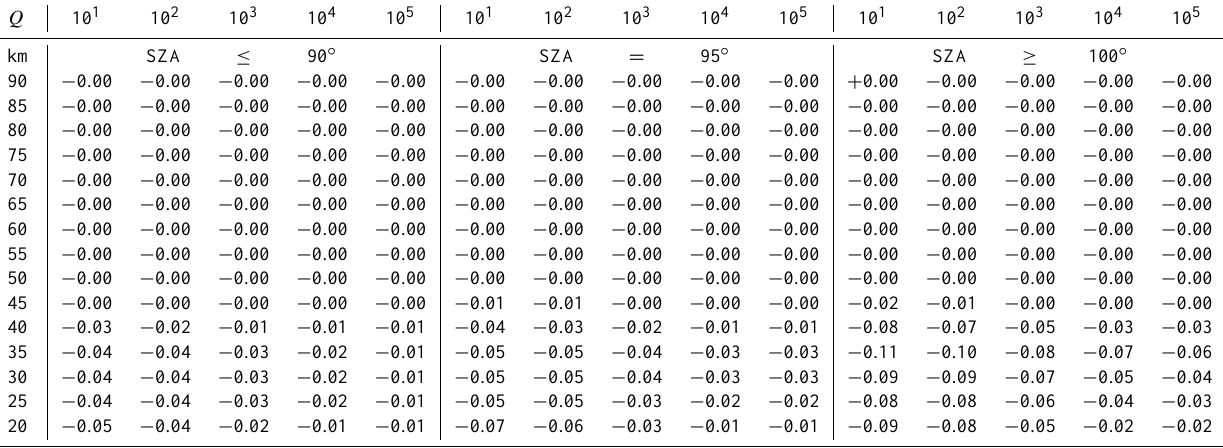
/Q for October SH. 2 O 5